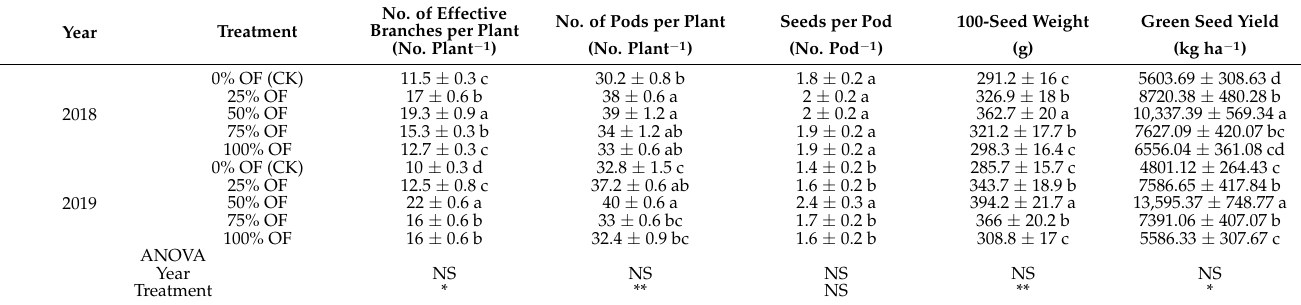
Table 2. Green seed yield and measurements of yield components for different treatments.